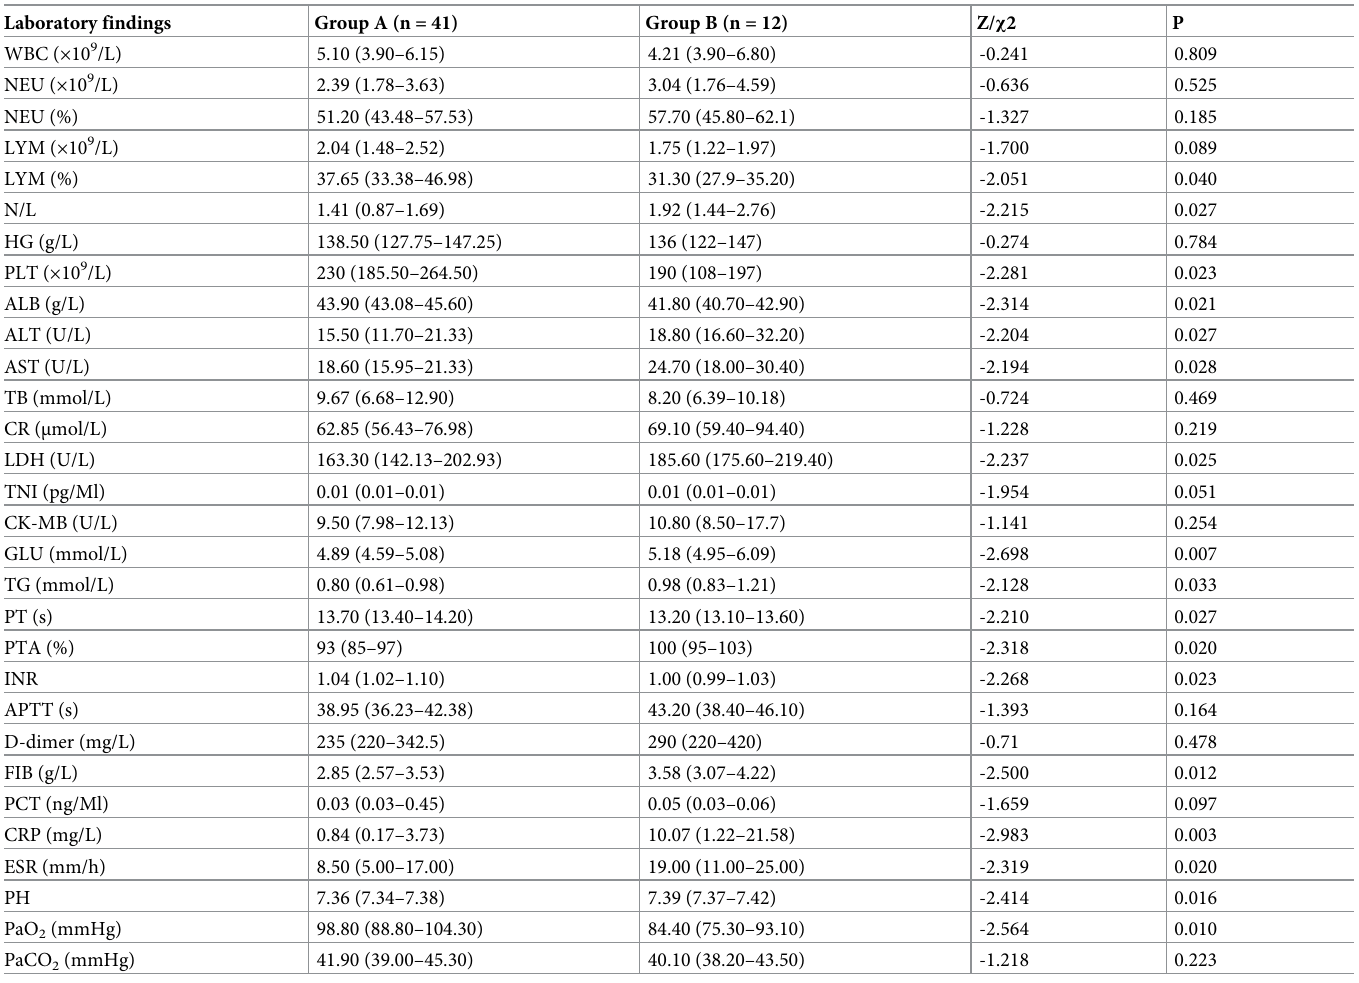
Table 3. Laboratory examination outcomes of the two